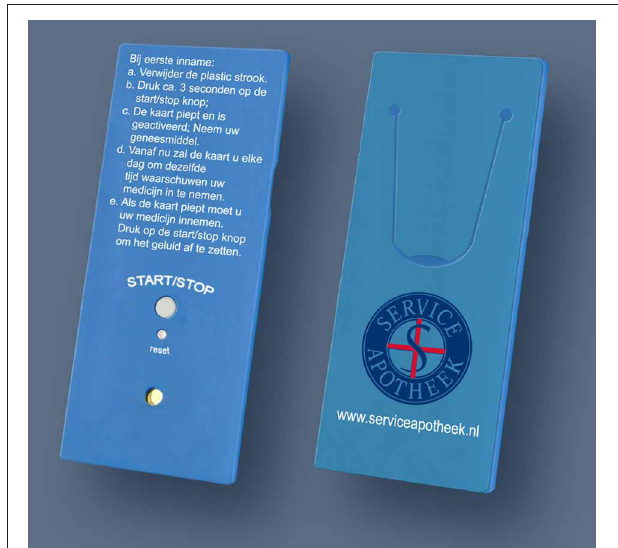
FIGURE 2 | ERD, Compliance Card ® . This credit-card size ERD needs to be activated after the first dose and gives a signal after every 24-h interval following its activation. It actively needs to be turned off. An instruction for the first use is printed on the